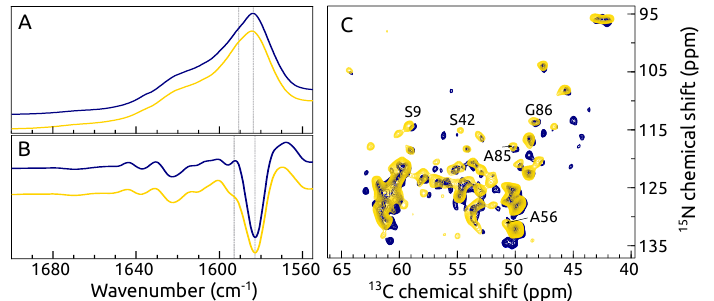
Figure 9. ( A ) FTIR spectra ( B ) the second derivative of FTIR spectra and ( C ) the overlay of 2D NCa ssNMR spectra of two 13 C, 15 N labeled α -syn samples: navy— α -syn fibrils, yellow— α -syn aggregated in a presence of S100A9. Protein solution for aggregation: 70µM α -syn, 0µM or 70µM S100A9, PBS, 0.02% NaN 3 ,